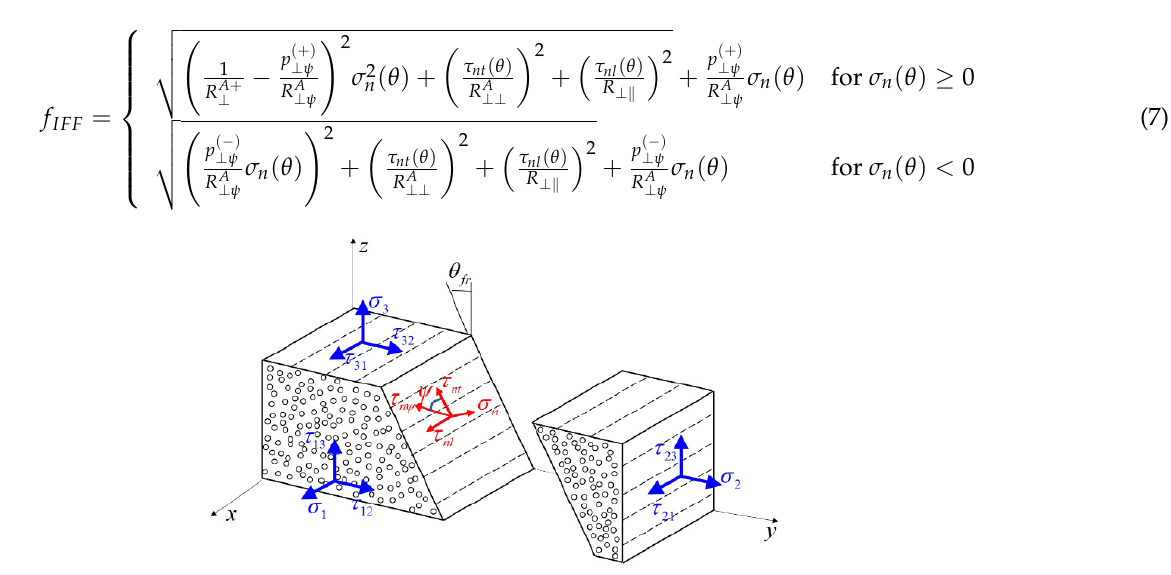
Figure 6. Stress components acting on potential fracture plane. (Blue stresses are in global coordinate system and red stresses are in local coordinate system.)